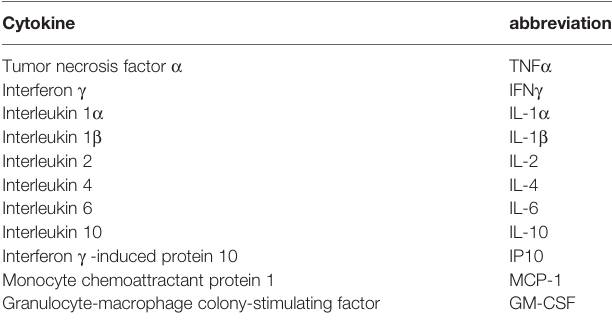
TABLE 7 | Cytokine pro fi les measures by Luminex ™ (MAGPIX ® ).